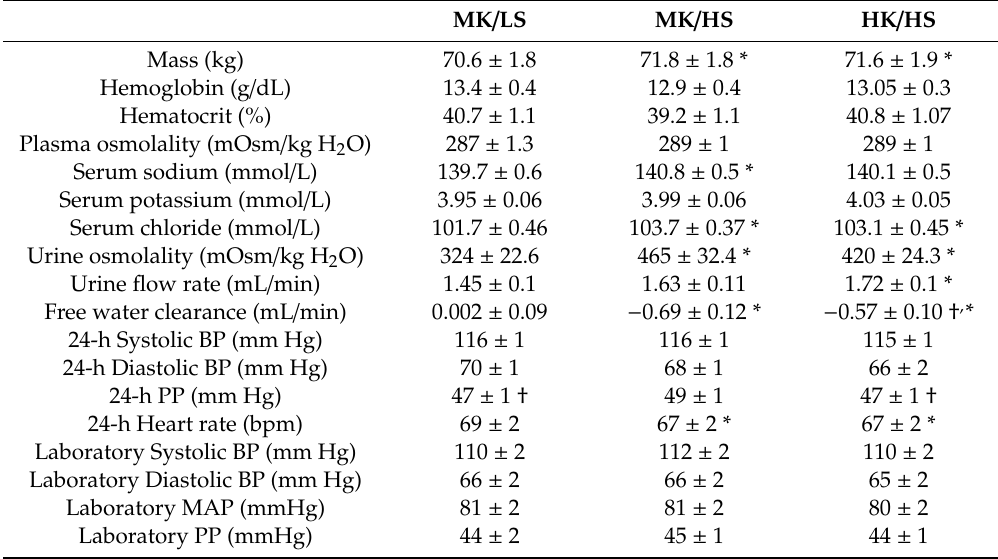
Table 2. Hemodynamic and renal responses to dietary potassium and sodium